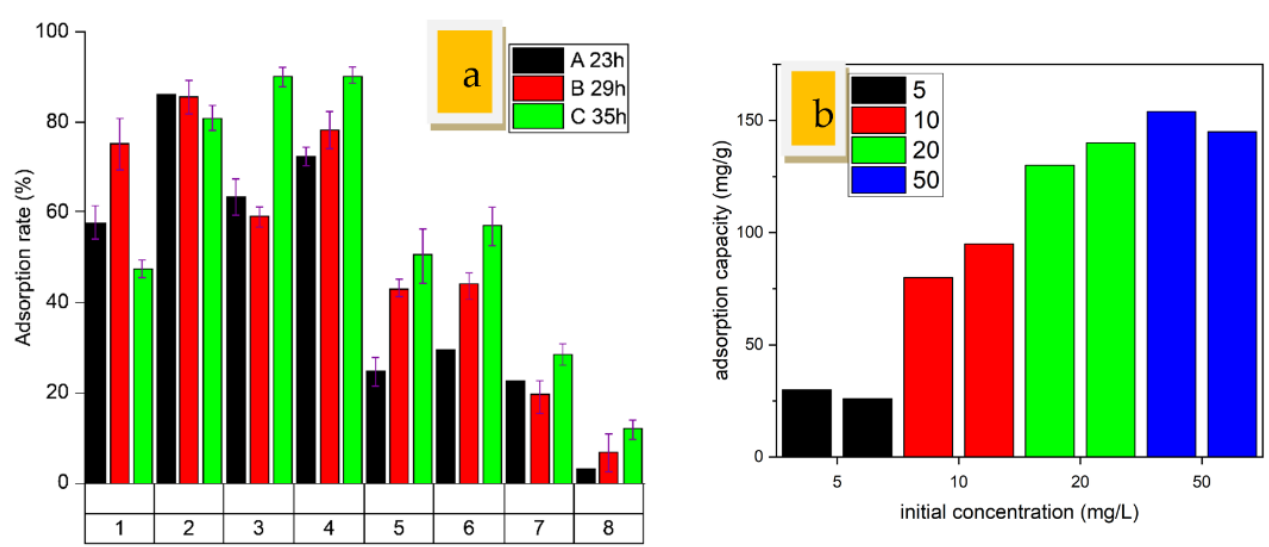
Figure 3. Adsorption rate ( a ) and capacity ( b ) by agar – La under different initial concentrations of phosphorous. The numbers 1 to 8 on the x-axis represent 5, 5, 10, 10, 20, 20, 50, and 50 mg/L, respec- tively.